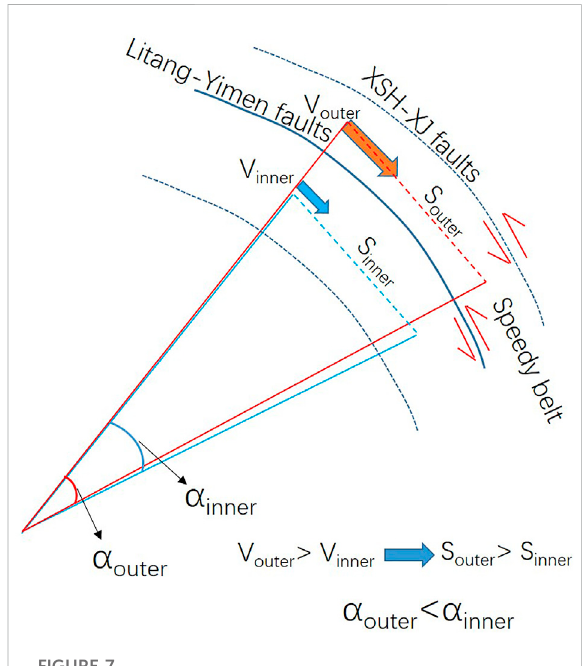
FIGURE 7 A Schematic diagram showing thespeedy belt from GPS data and fault deformation near its west